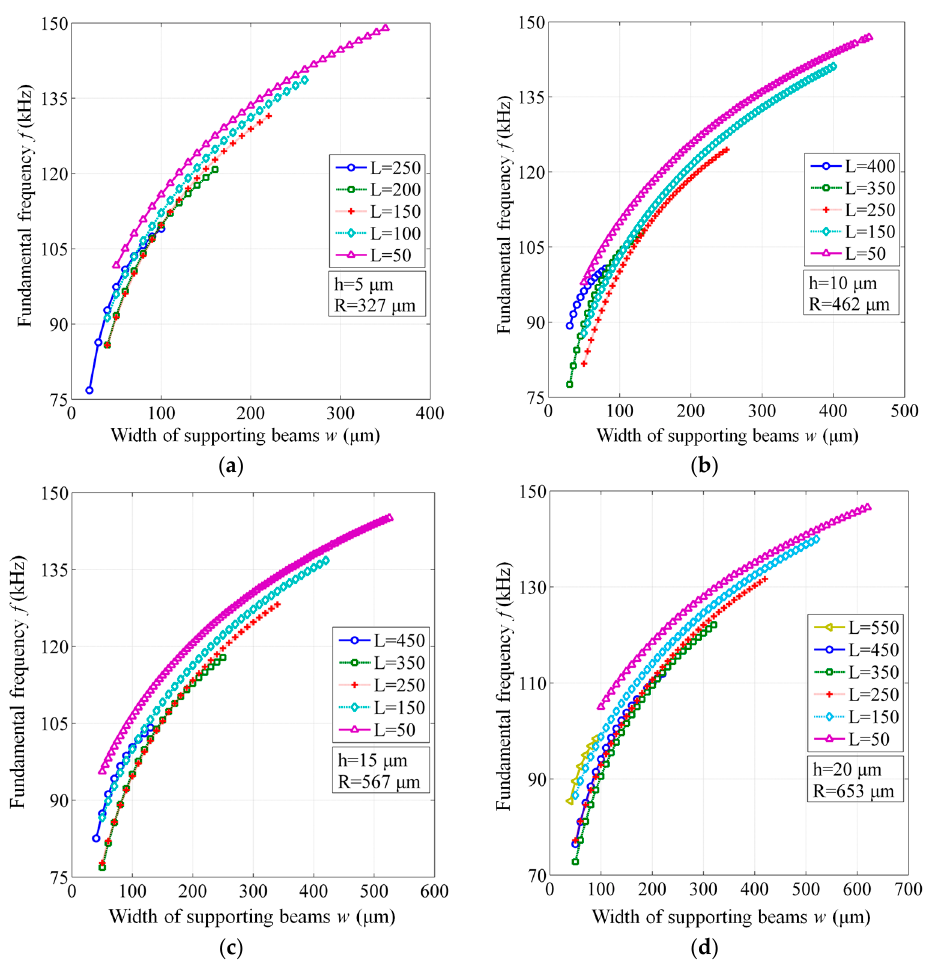
Figure 3. Fundamental frequency of BSM structures for different geometrical dimensions, compared to a constant value of 180 kHz for the IM structures. ( a ) Membrane thickness h = 5 μ m and radius R = 327 μ m; ( b ) h = 10 μ m and R = 462 μ m; ( c ) h = 15 μ m and R = 567 μ m; ( d ) h = 20 μ m and R = 653 μ m.